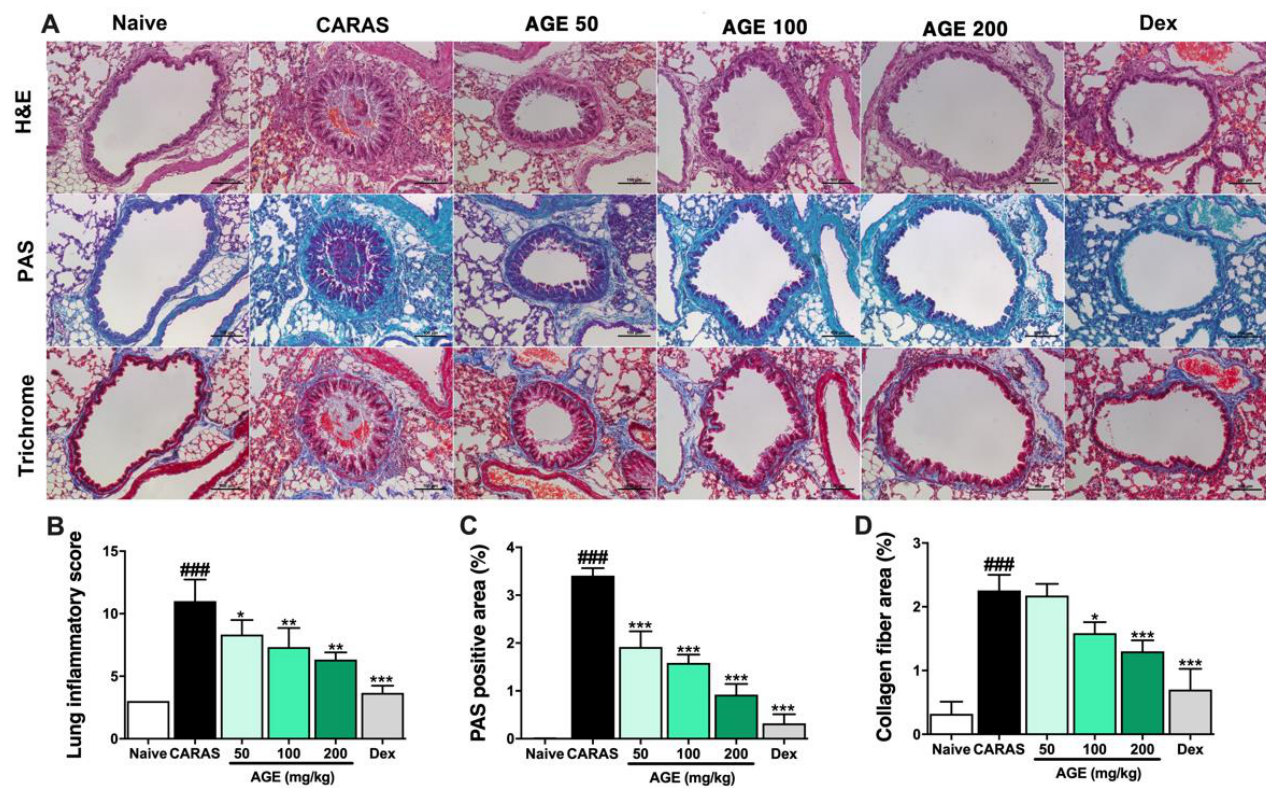
Figure 4. AGE effectively suppressed inflammation, mucus secretion, and collagen deposition in the lung tissue of CARAS mice. ( A ) The histology of lung tissue. ( B ) Lung inflammation score. ( C ) PAS-positive area. ( D ) Collagen fiber area. All pictured were at a magnification of 200×. By H&E staining, typical inflammation features were observed in lung tissue of CARAS mice: bronchial smooth muscle thickened, bronchial epithelium cells were swelling, and alveoli surrounding bronchia were majorly penetrated with inflammatory cells. By PAS staining, CARAS mice showed an increase in goblet cells resulting in over-secreted mucus into the lumen of the bronchia. By trichrome staining, the collagen fiber (which was stained by blue color) was abundantly expressed surrounding the bronchi and vessels in the lung tissue of CARAS mice. However, the inflammation and goblet cell hyperplasia in CARAS mice were considerably attenuated by AGE and the collagen fiber deposition also lessened in the treatment group with AGE. All results are shown as the mean ± SD (n = 6 per group). # Compared to naive, * compared to CARAS. ### , *** p < 0.001; ** p < 0.01; * p < 0.05. CARAS = combined allergic rhinitis and asthma syndrome; AGE = Artemisia gmelinii extracts; Dex = dexamethasone; H&E = hematoxylin and eosin; PAS = periodic acid – Schiff. Scale bars = 100 µm.